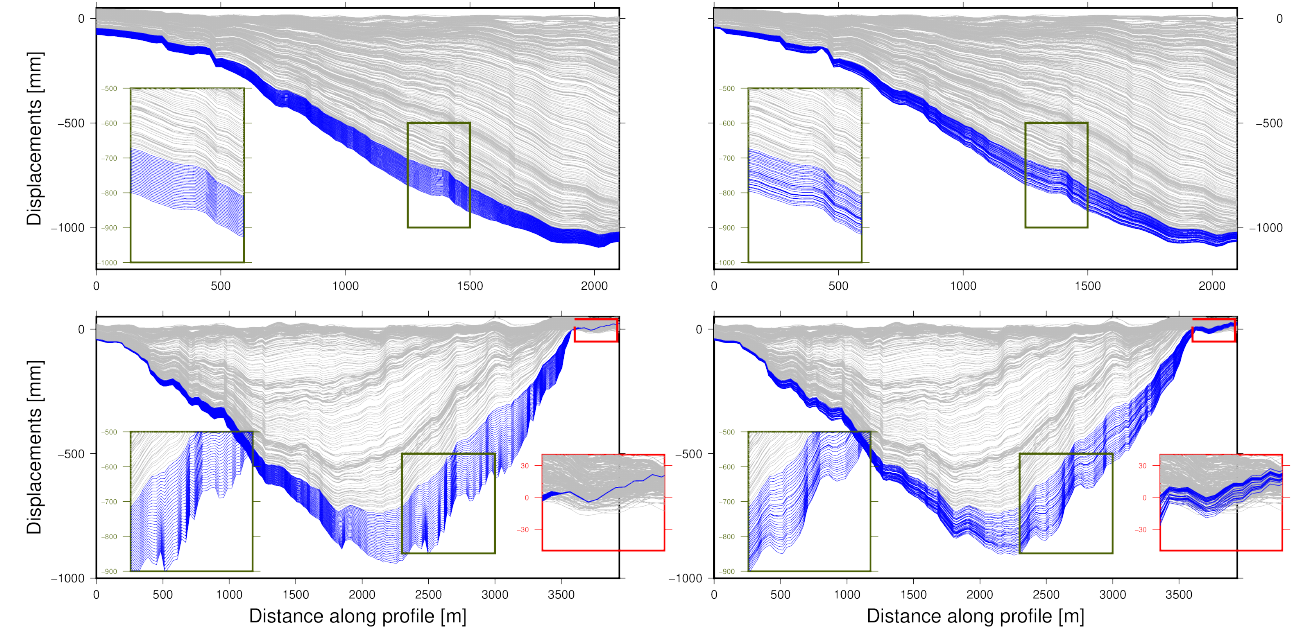
Figure 6. Representative forecast results for the 3rd ( bottom ) and 21st ( top ) subsidence troughs: for the ARIMA model (on the left ) and for the Holt model (on the right ). Featured and enlarged areas (green polygons) show increments dynamics of the forecast results. The areas bounded by the red polygon show displacement forecasts are locally positive, which is in contrast to the actual